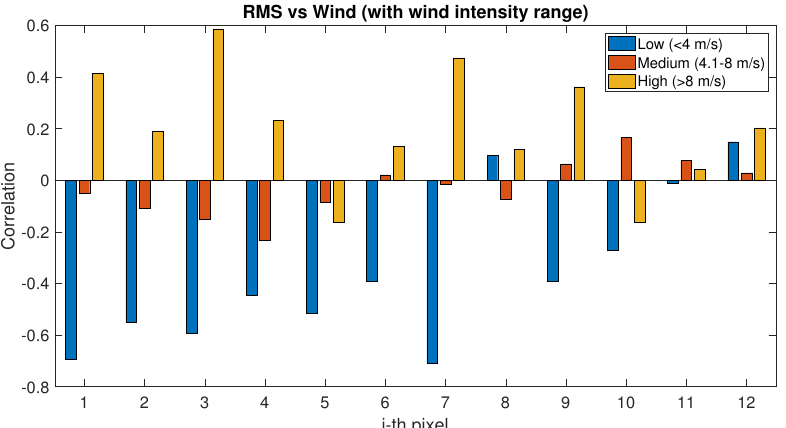
Figure 13. Correlation factor between RMSH and wind speed evaluated for low-, medium- and high-wind-speed conditions.